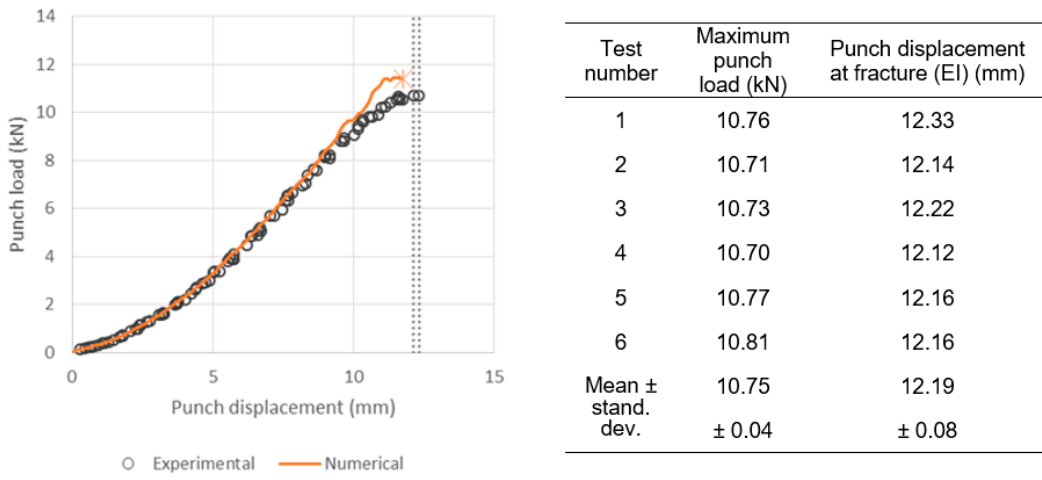
Figure 6. Erichsen test of the EK4 steel: average experimental and numerical punch load–displacement curves where the dotted lines indicate the fracture range measured in the tested specimens.